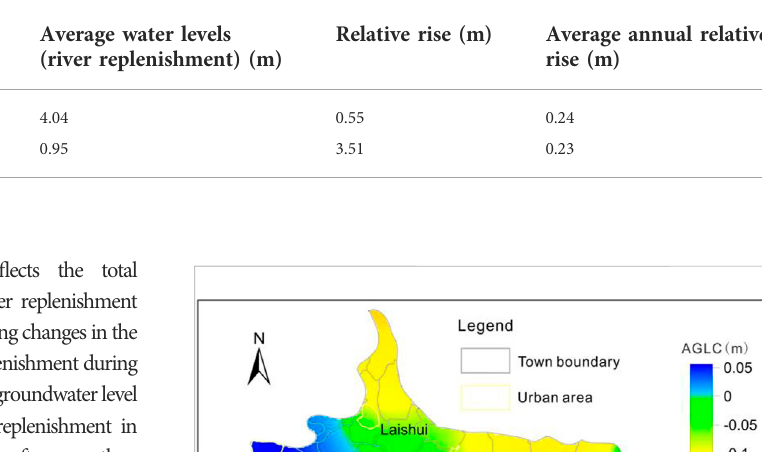
TABLE 1 Comparison of the average groundwater levels.